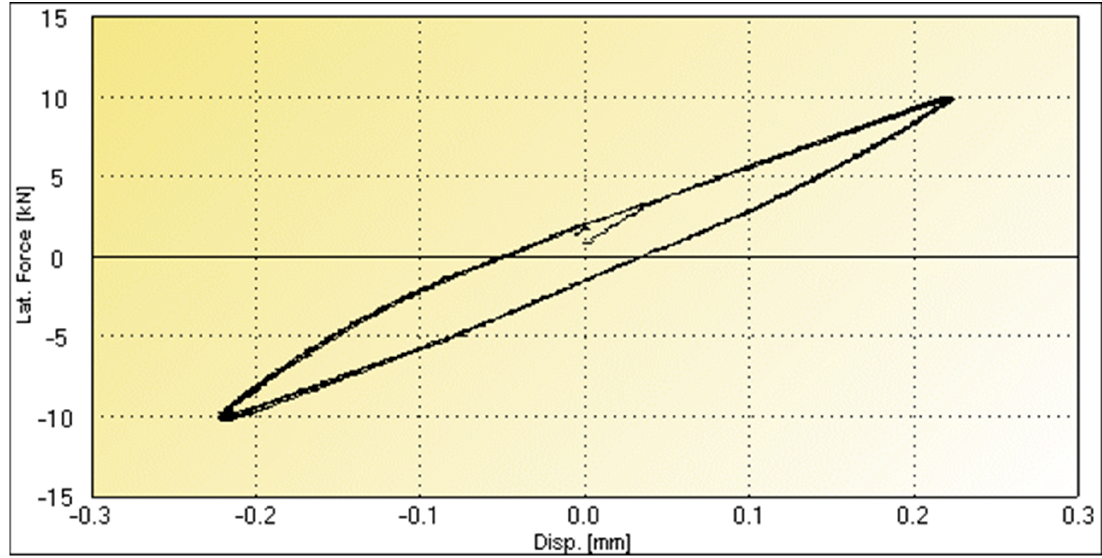
Figure 6. Force–displacement graph for sample under compression and tension.